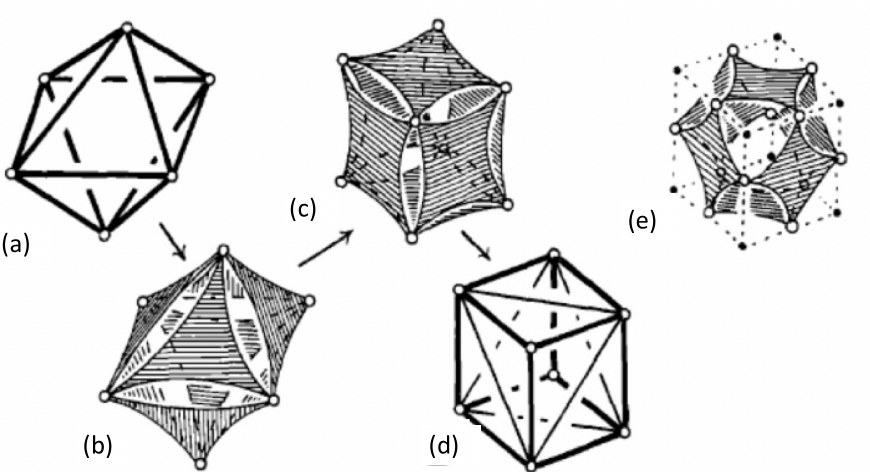
Figure 38. The opposite faces of an octahedron form an isostatic jointed-sheetwork ( b ), with the full octahedron as a bar-and-joint model ( a ). A polar of ( b ) is ( c ) as the sheet cube ( d ). Figure ( e ) is the different polar of ( a ) where the bars in ( a ) become 2-valent sheets and the vertices will polarize to 4-valent sheets. Figures are adapted from